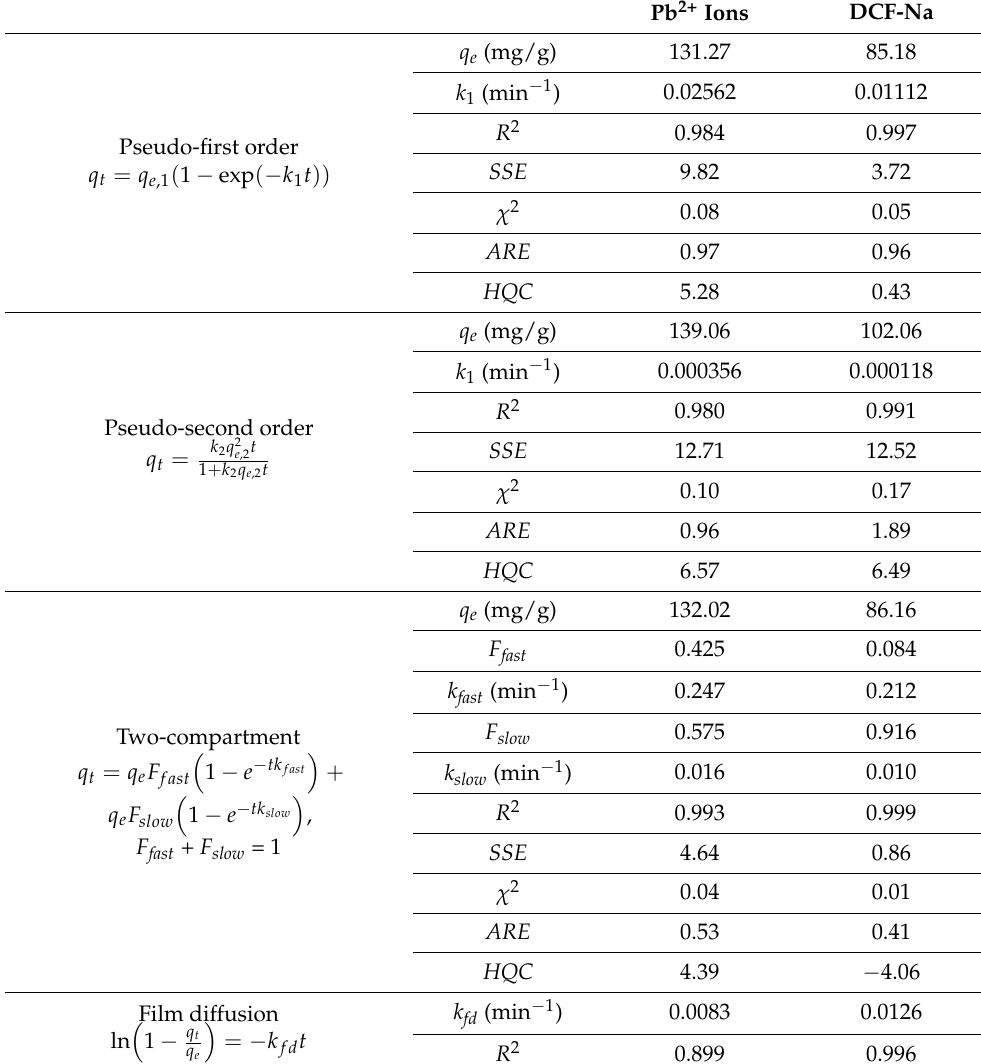
Table 3. Kinetics parameters for Pb 2+ ions and DCF-Na simultaneous sorption on IS/(PEI/PMAA) c (r = 1.0).